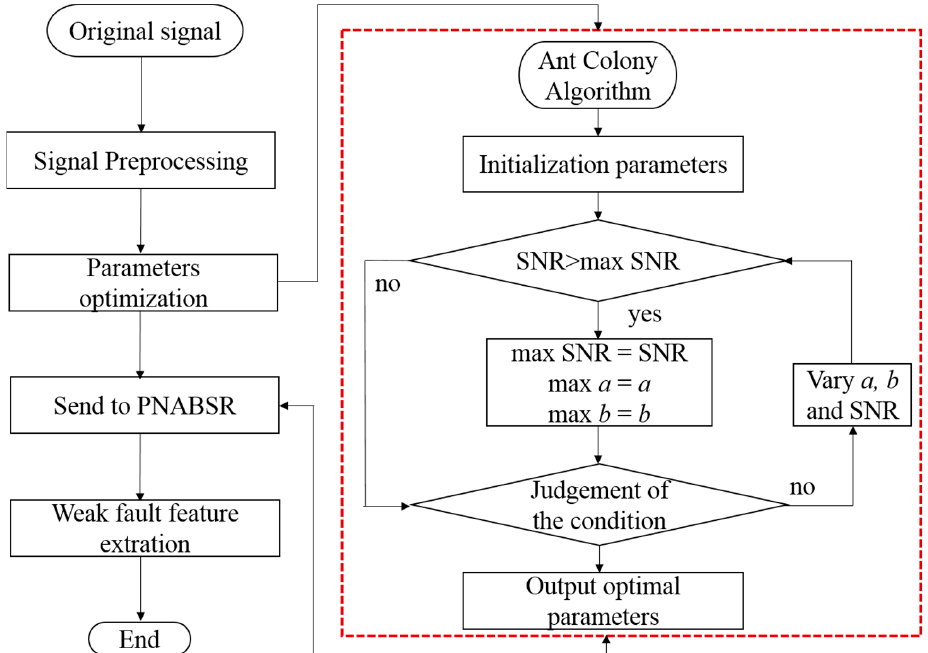
Figure 7. Optimization of PNABSR model parameters.